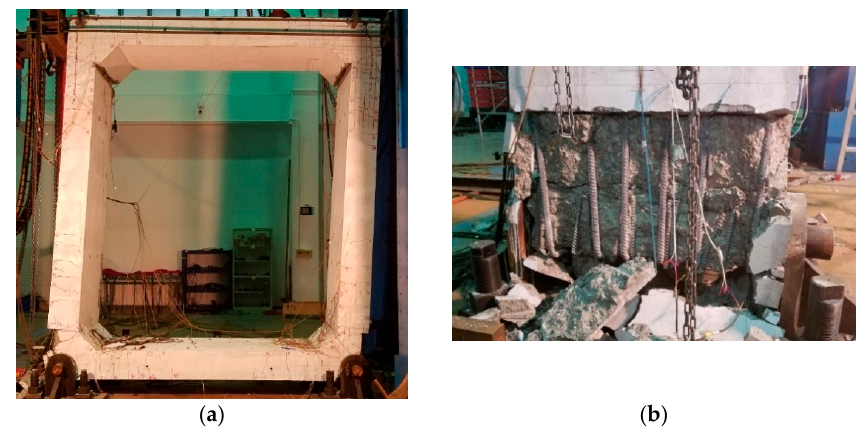
Figure 3. Test setup.